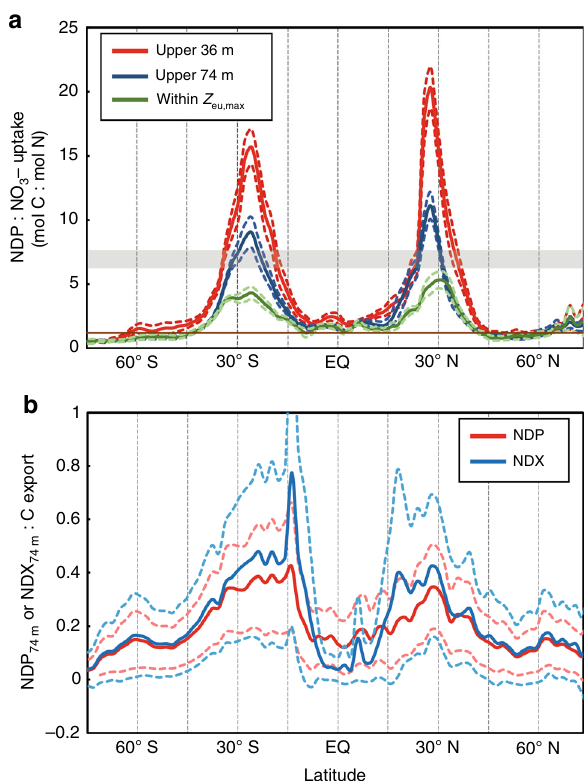
Fig. 3 Latitudinal variability of DOC production and export to NO 3 − uptake and C export. a Zonally averaged ratios of net DOC production (NDP) to NO 3 − uptake within the upper 36 m (solid red line with dashed red lines indicating ± 1 standard deviation), 74 m (solid blue line with dashed blue lines indicating ± 1 standard deviation), and the deepest euphotic zone over the course of the year ( Z eu,max ; solid green line with dashed light green lines indicating ± 1 standard deviation). Also shown is the global average ratio of C:N in POM (gray shading; ref. 9 ) and the mean NDP:NO 3 − uptake ratio estimated in a previous study for the Atlantic Ocean (solid brown line; refs. 7,8 ). b Ratios of zonally averaged NDP (solid red line with dashed light red lines indicating ± 1 standard deviation) and net DOC export (NDX; solid blue line with dashed light blue lines indicating ± 1 standard deviation)